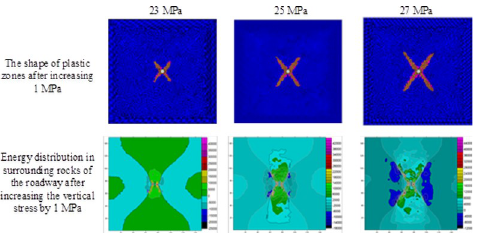
Fig 10. The shape of the plastic zone and the energy distribution of the surrounding rock of the roadway after the vertical stress increases by 1 MPa under different abutment pressures (23-27MPa).